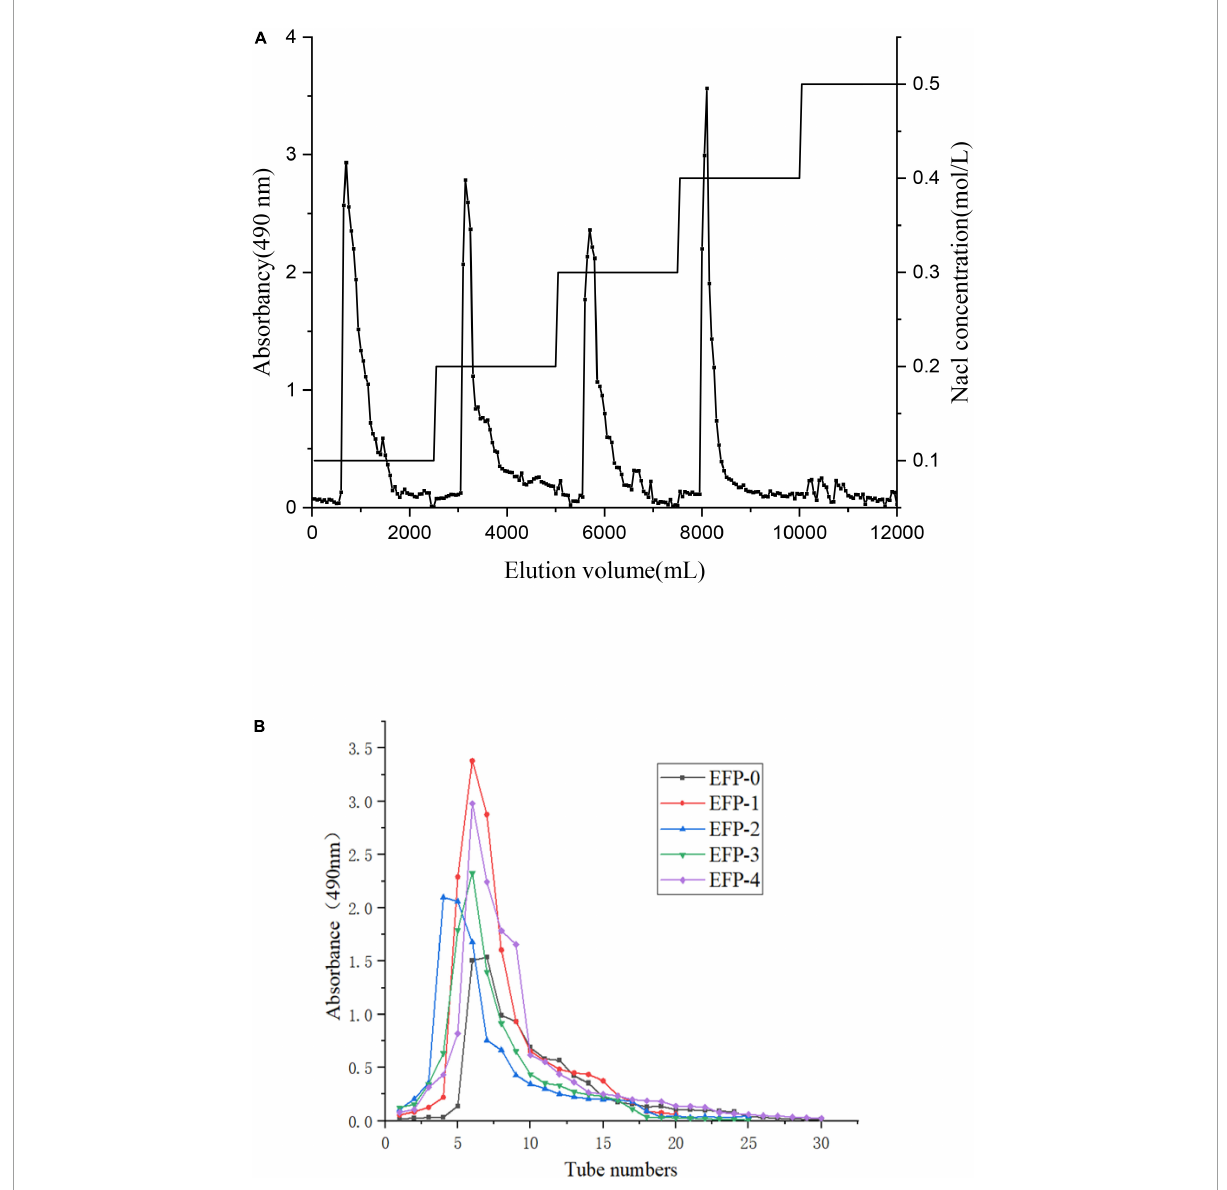
FIGURE2 Isolation and purification of five polysaccharide fractions from elderberry fruits. (A) Elution profile of elderberry polysaccharides on a DEAE cellulose-52 column. (B) Elution profiles of five fractions (EFP-0, EFP-1, EFP-2, EFP-3, and EFP-4) on a Sephadex G-100